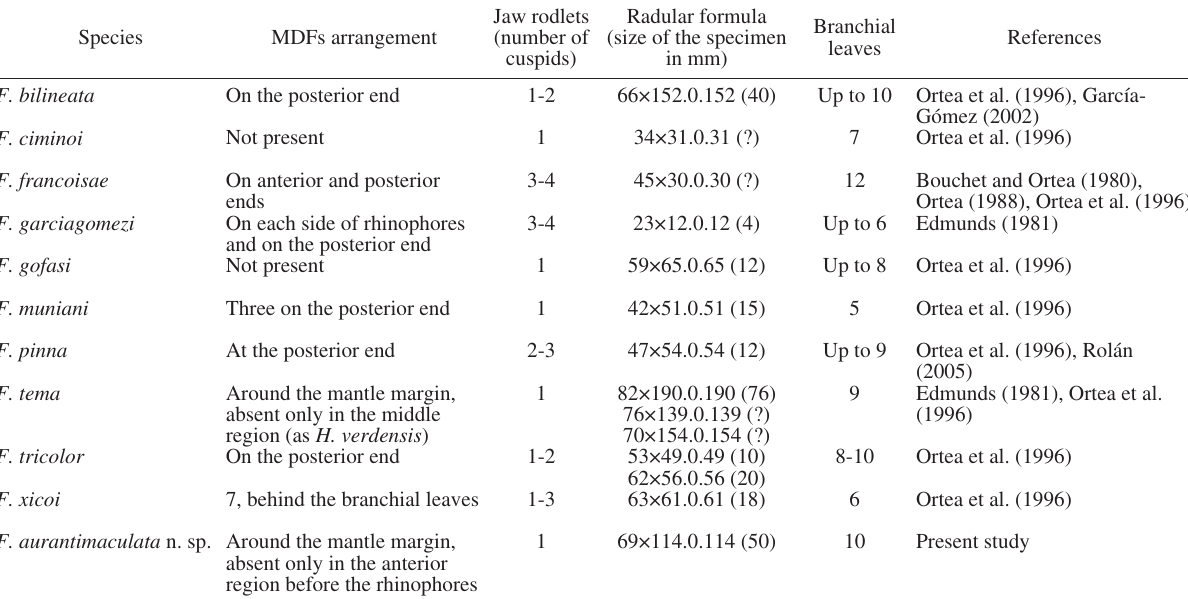
Table 4. – Comparative table of the main features for Felimare species belonging to the blue Atlantic chromatic group distributed along the western African